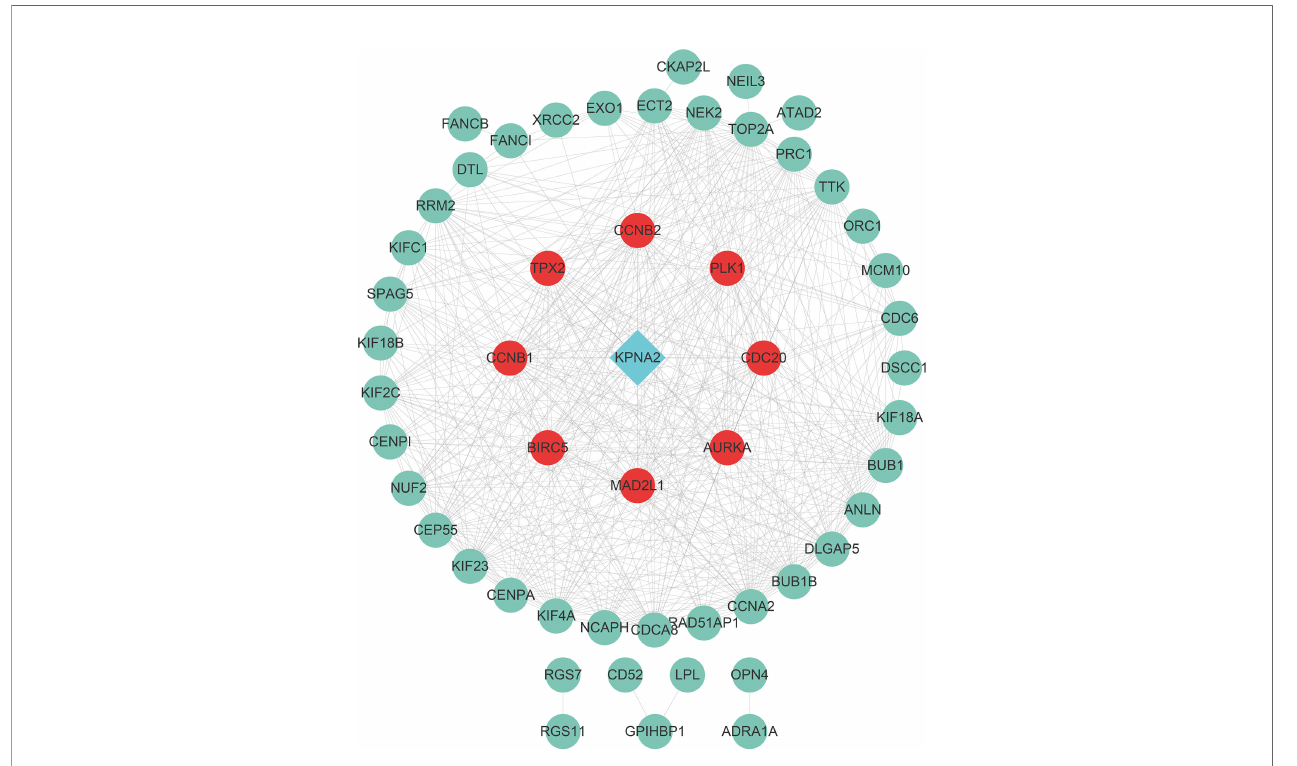
FIGURE 5 | PPI network constructed from co-expression gene. Genes with red dots were directly associated with KPNA2 and were considered hub